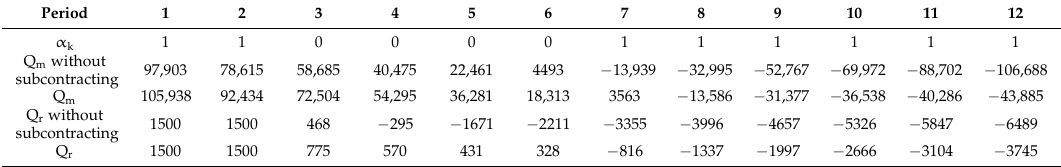
Table 9. Amount of emitted carbon during the different process with Q cm = 118,000 and Q cr = 1500. Period